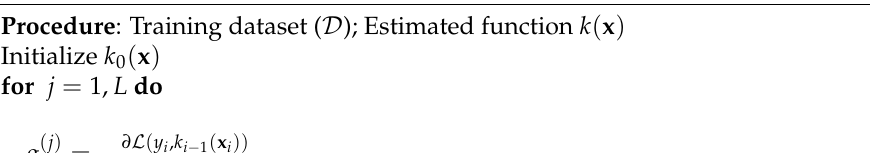
Algorithm 1 The GBA model for